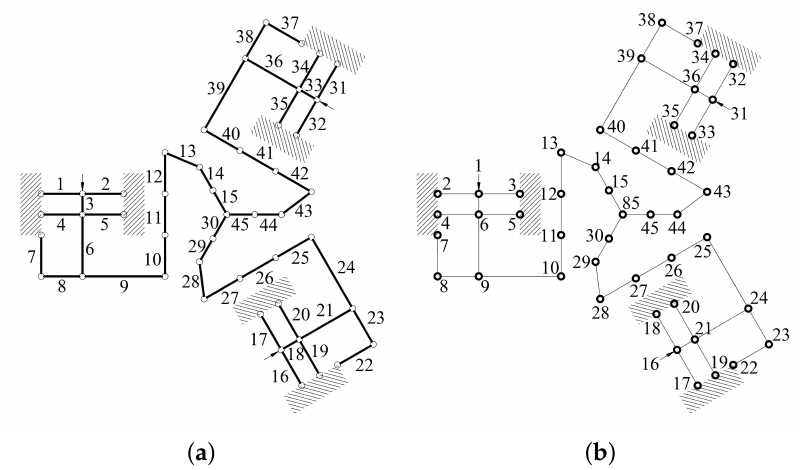
Figure 8. Simplified equivalent statics model of three in-plane branched chains. ( a ) Frames; ( b ) nodes. Second, the three out-of-plane parallel-kinematic branched chains were analyzed. This analysis involved nine right-circular SaNFHs, six corner-filled SaNFHs, and twenty-four flexible beams. The nodes and frames of the out-of-plane stiffness model are shown in Figure